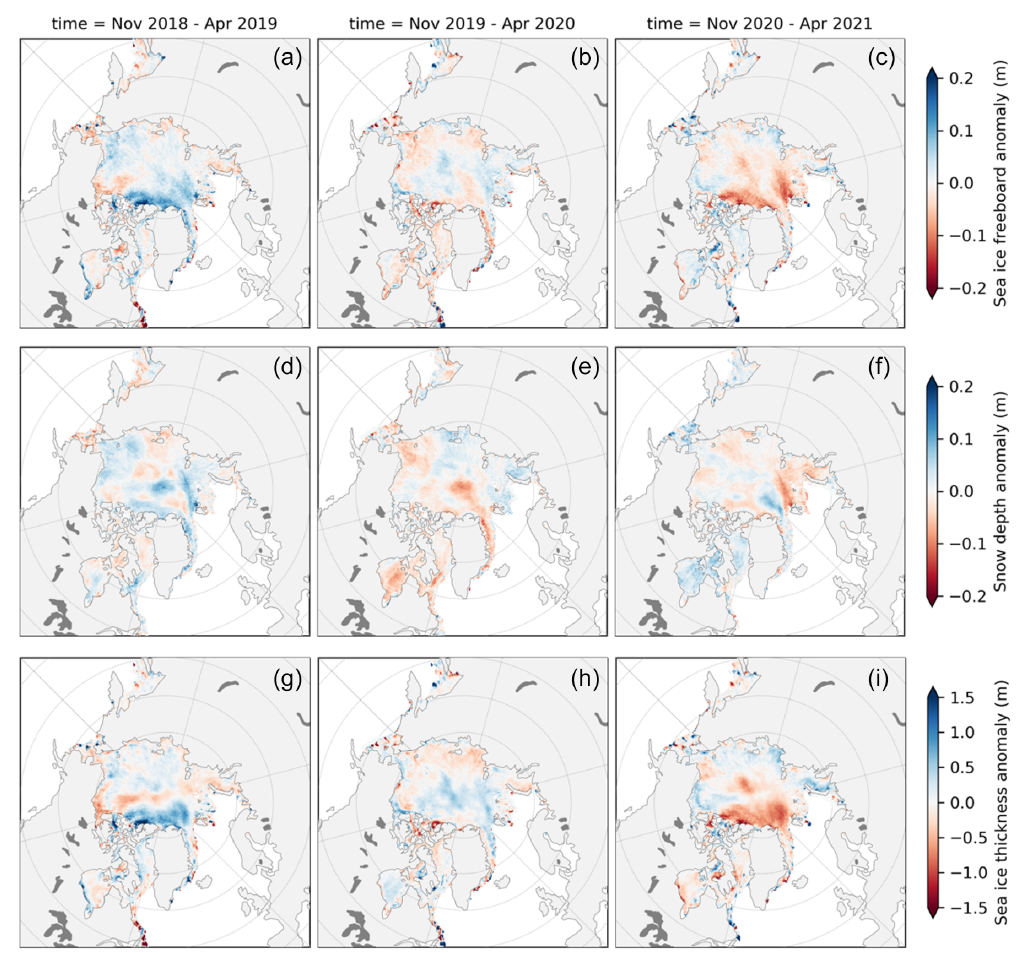
Figure 14. As in Fig. 13 but showing the anomalies relative to the 2018–2021 winter means for the 2018–2019 ( a , d and g ), 2019–2020 ( b , e and h ) and 2020–2021 ( c , f and i )